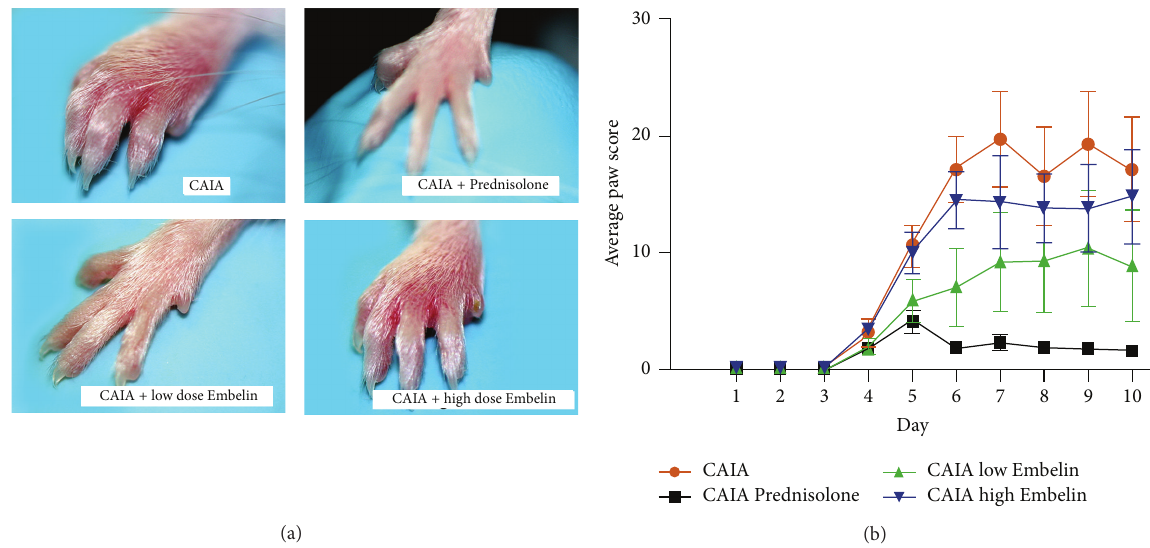
Figure 1: (a) Representative clinical features of mouse paws in CAIA untreated mice, Prednisolone treated CAIA mice, CAIA mice treated with low dose Embelin, and CAIA mice treated with high dose Embelin. (b) Mean clinical paw scores of each study group throughout the experiment. Error bars represent standard error of the mean (SEM).